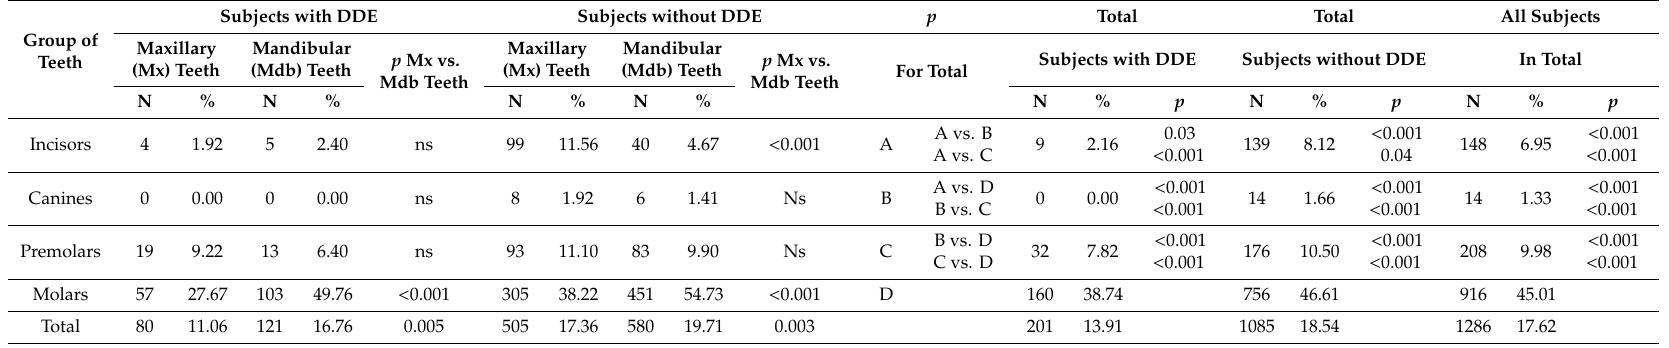
Table 9. Comparison of the number of teeth groups a ff ected by caries (with carious cavities, fillings and extracted due to decay) between subjects with and without enamel